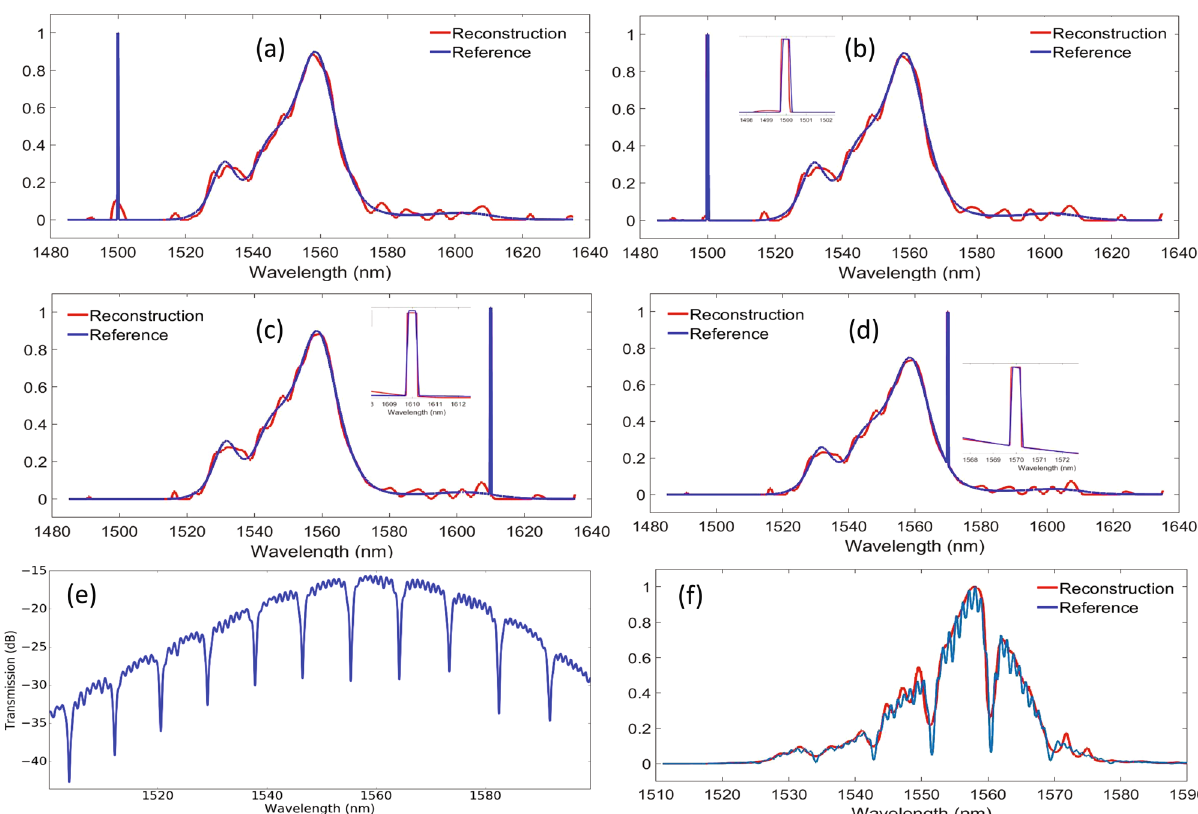
Fig. 5 Experimental validation and characterization of the single-shot SWF-based spectrometer for hybrid spectra that contain both broad spectral components (e.g., ASE source) and narrow spectral peak or notches. a Results obtained without further optimization of the reconstruction algorithm using Eqs. (4 – 5) showing poor quality in revealing the narrow spectral peak signals and the reference from a commercial optical spectrum analyzer (in blue). b – d Results obtained from using advanced reconstruction algorithm of Eq. (7) showing good reconstruction quality of all the three narrow spectral peak signals at different locations. Insets in ( b – d ) show the zoom-in area around the narrow line signals. e shows the notches generated by a ring resonator at a different chip. f Plots the reconstruction of the broadband spectrum with narrow notches (in cyan). Even if the performance compared degrades compared with a reconstruction of pure broadband spectrum, but the individual notches and the overall envelope can be accurately